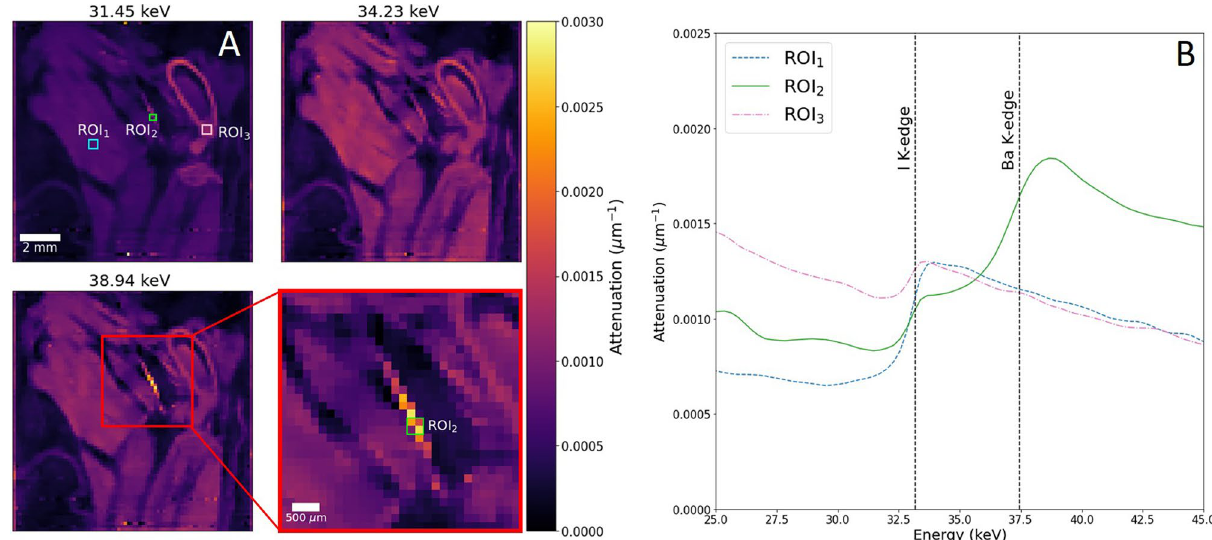
Figure 2. Voxel spectra analysis for double-stained hindlimb specimen. ( A ) Single image slice in the sagittal plane across three monochromatic energy channels, following iterative reconstruction. A set of three regions- of-interest (ROIs) are highlighted for voxel spectra analysis. An enlarged image of a section of ( A )—red box—is included to highlight ROI 2 taken over one of the distinct material phases. ROIs 1,3 cover a 3 × 3 voxel region, while a 2 × 2 pixel region is used for ROI 2 , partially overlapping with surrounding material outside of the phase. ( B ) Voxel spectra for each ROI, showing clear steps in attenuation. Known absorption edge positions (black dotted lines) confirm the presence of iodine and barium in the ROIs, while ROI 3 shows a small iodine signal, having partially diffused into the calcium-containing bone.